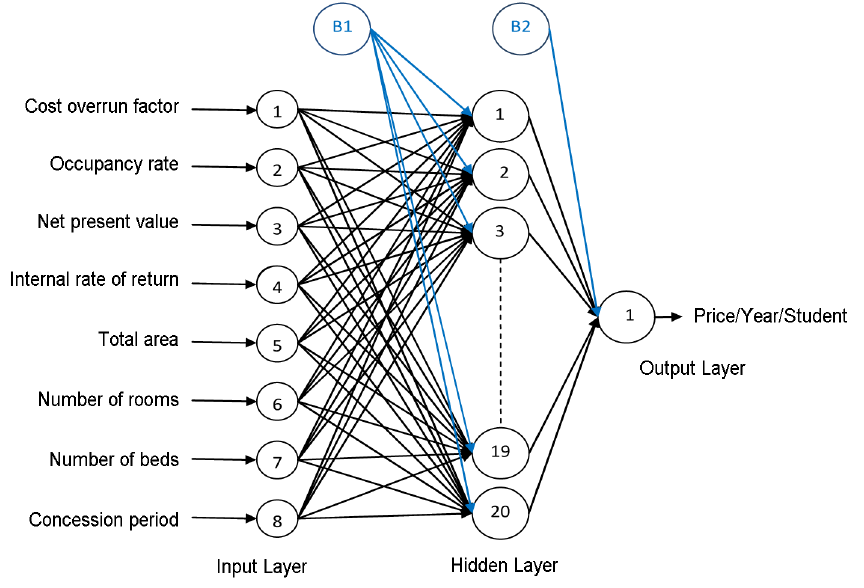
Fig. 3. Artificial neural network architecture